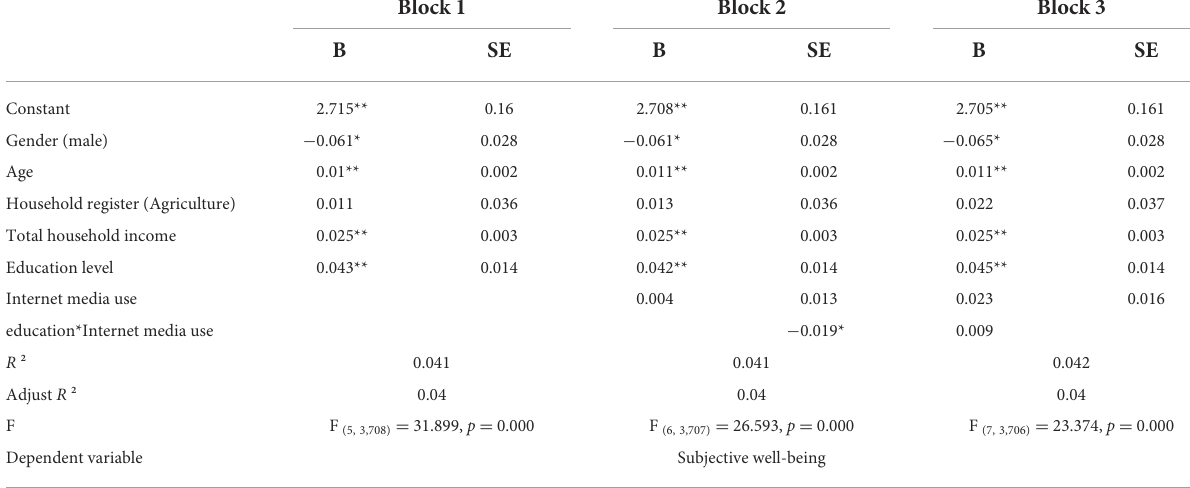
TABLE 11 Results of hierarchical regression analysis